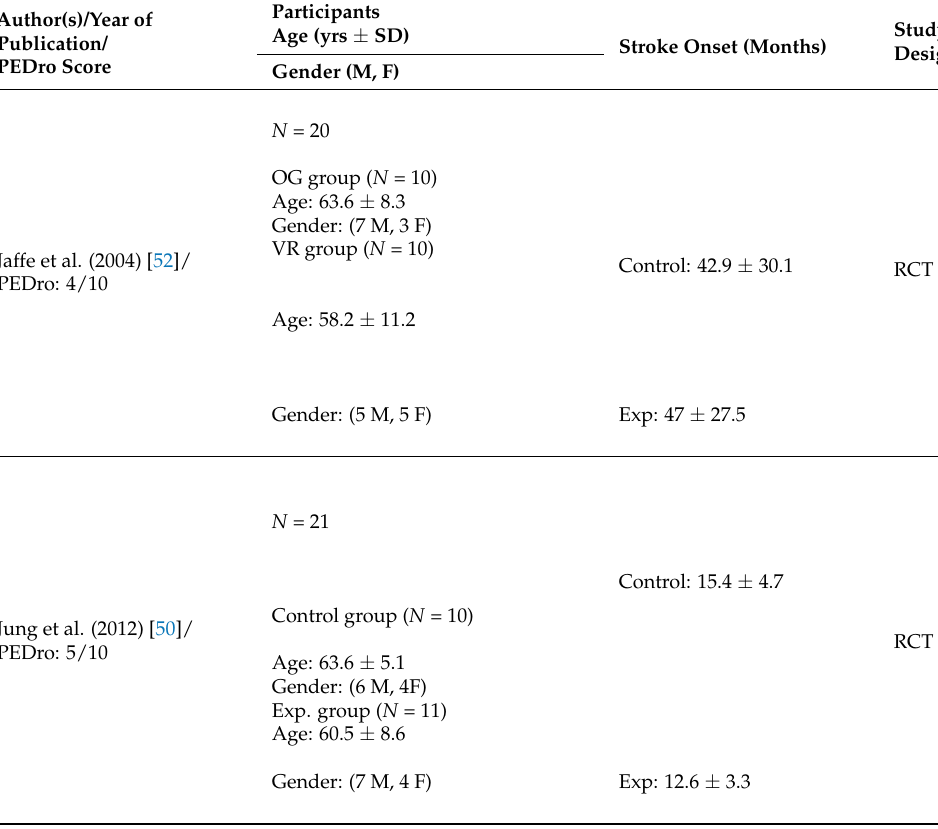
Table 1. Characteristics of the included